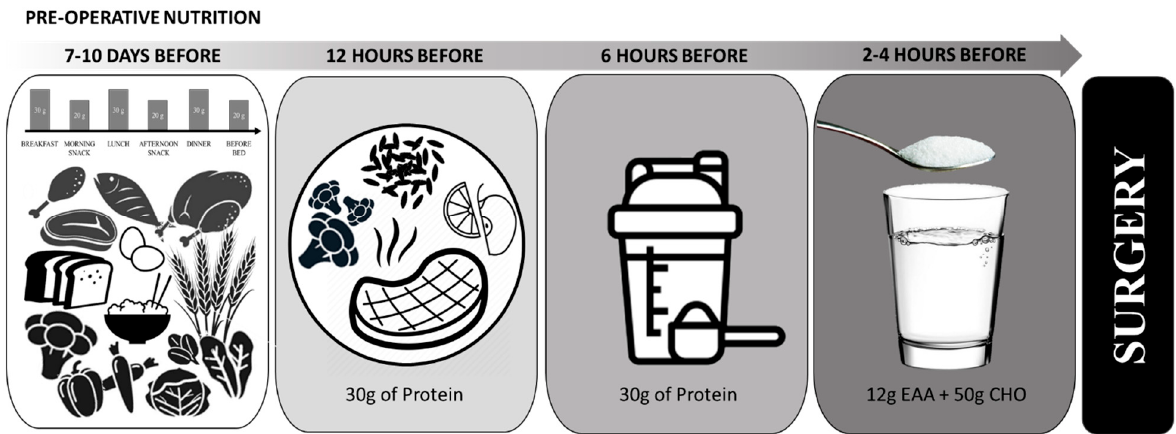
Figure 1. Example of pre-operative nutrient timing leading up to surgery. Modified from Smith-Ryan et al. (2020). Protein intakes of 1.2–2.0 g/kg/day from high-quality protein sources distributed